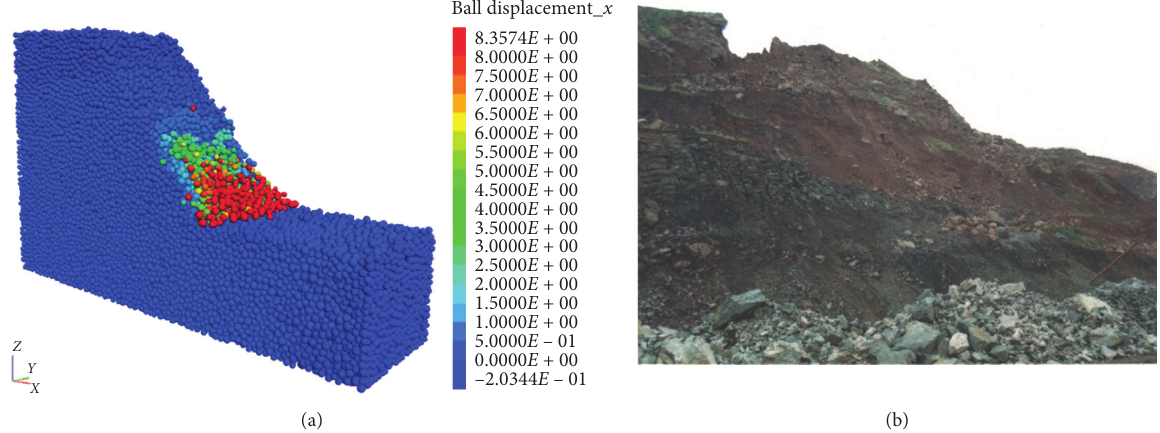
Figure 22: Failure mode of the slope: (a) simulation result; (b) current